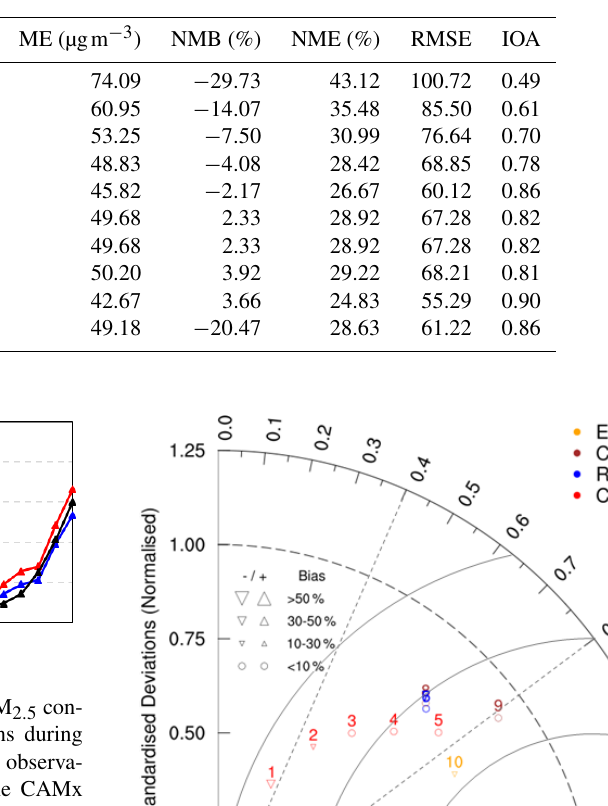
Table 4. Statistical measures of the modelled daily PM 2 . 5 in Xi’an (unit: µgm − 3 ).